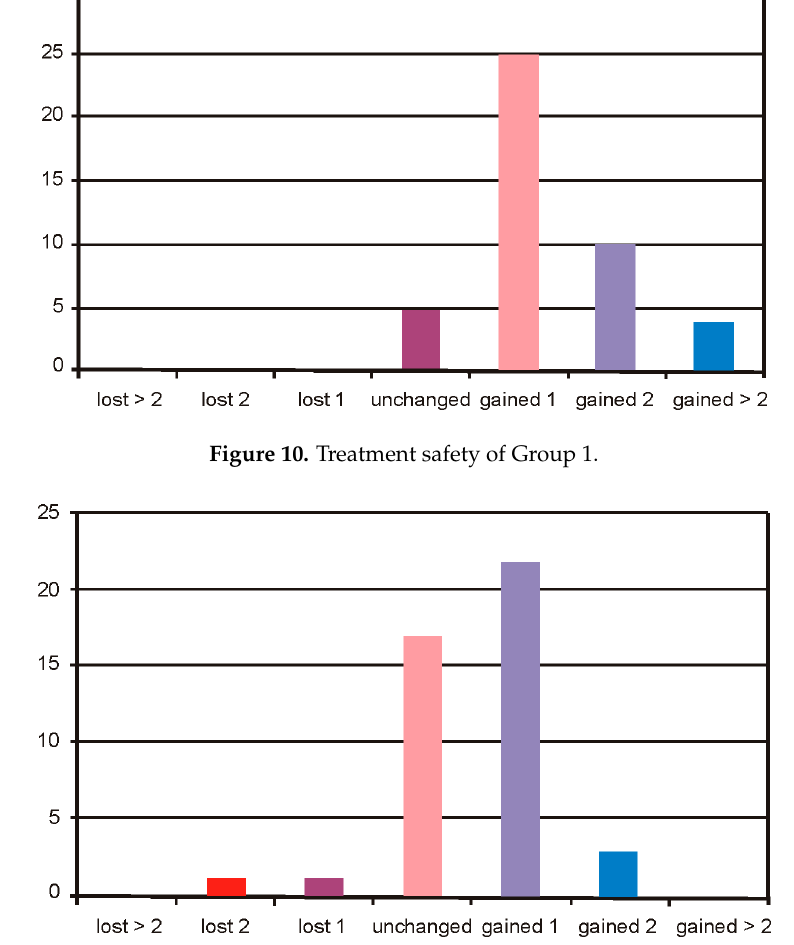
Figure 11. Treatment safety of Group 2.